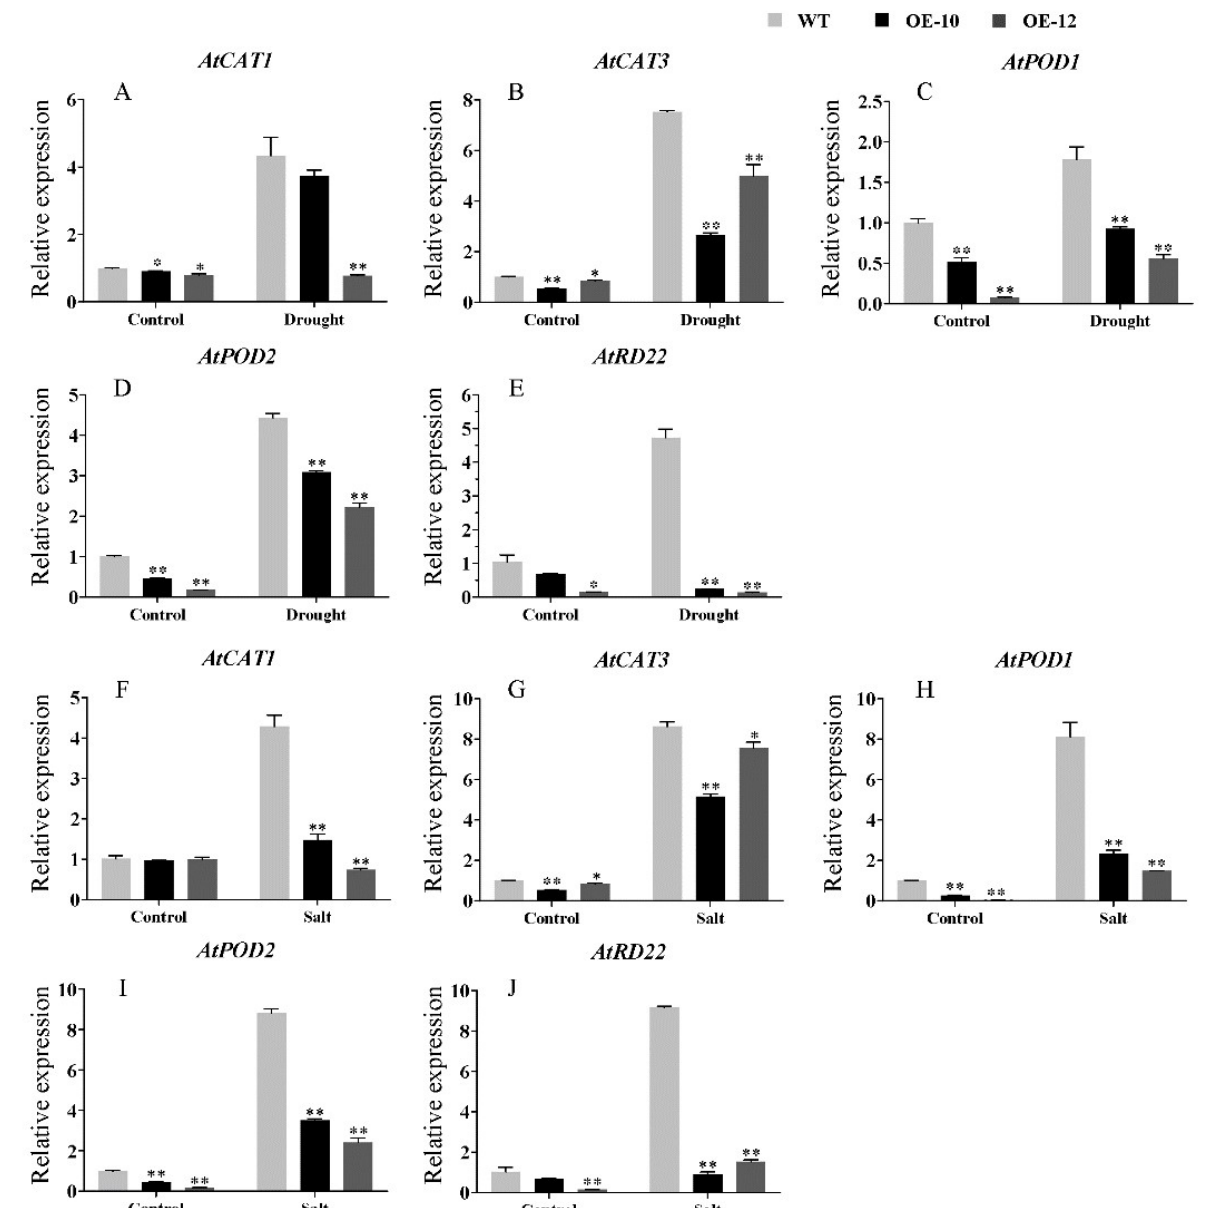
Figure 10. The expression of abiotic stress-related genes in the WT and AcWRKY31 transgenic Arabidopsis plants in response to drought ( A – E ) and salt stresses ( F – J ). The error bars indicate ± SD ( n = 3 replicates). Asterisks indicate significant differences for the indicated comparisons based on Student’s t test (* p < 0.05, ** p < 0.01).